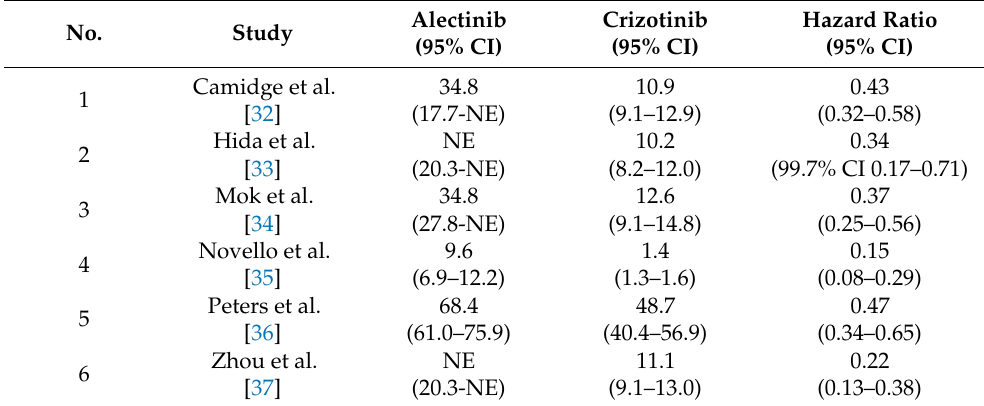
Table 4. Progression-Free Survival. (PFS;